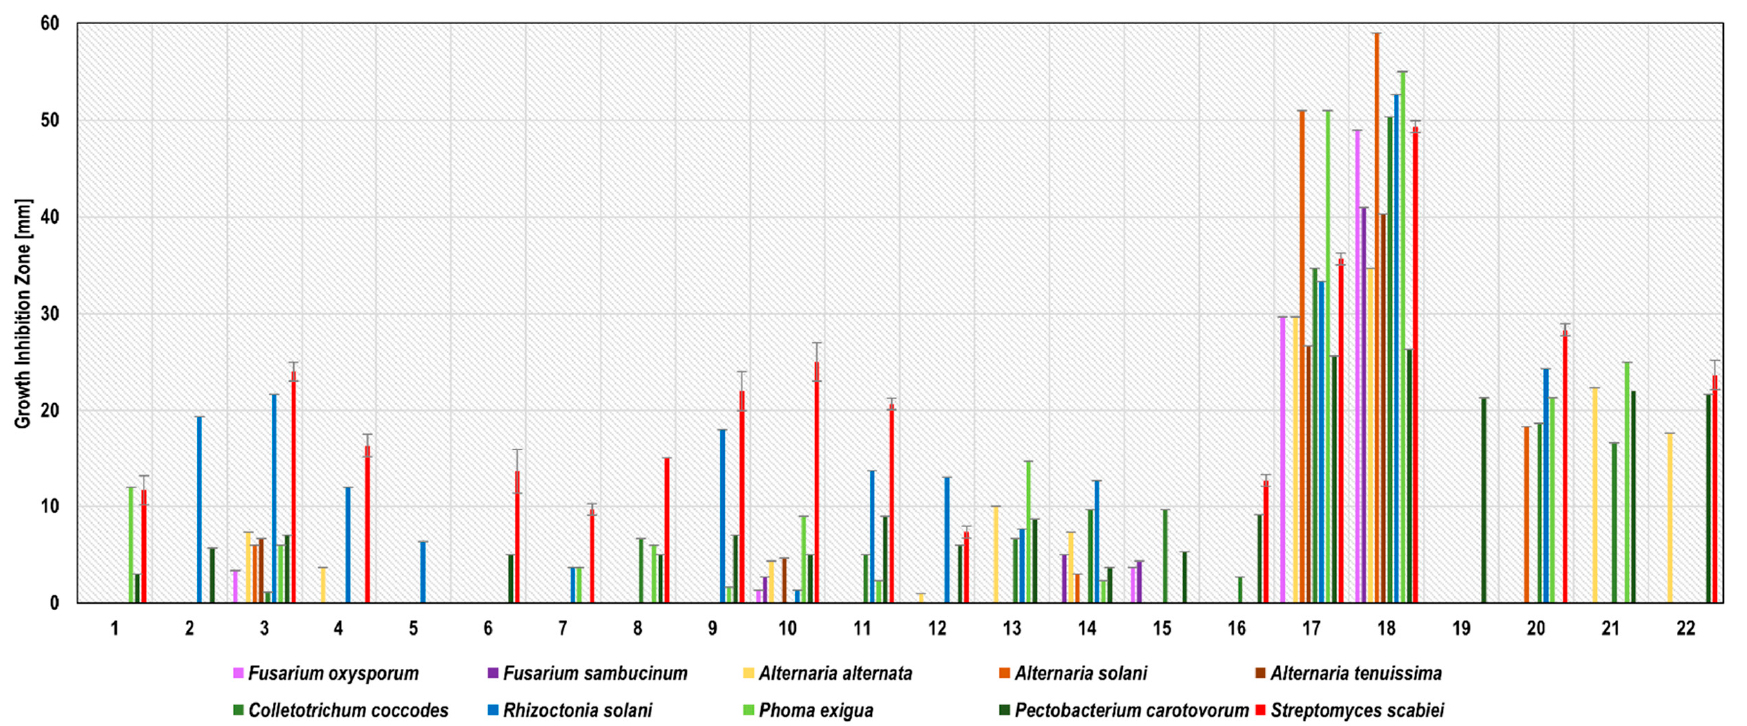
Figure 2. Activity of plant glycol-water extracts against potato seed phytopathogens measured as growth inhibition zones in the agar-well diffusion method. 1—common yarrow; 2—peppermint; 3—sage; 4—common horsetail; 5—nettle; 6—dandelion; 7—couch grass; 8—perforate St. John’s wort; 9—rosemary; 10—common hop; 11—summer savoury; 12—caraway; 13—blackseed; 14—thyme; 15—lavender; 16—horseradish; 17—garlic; 18—clove; 19—onion; 20—turmeric; 21—bistort; and 22—common